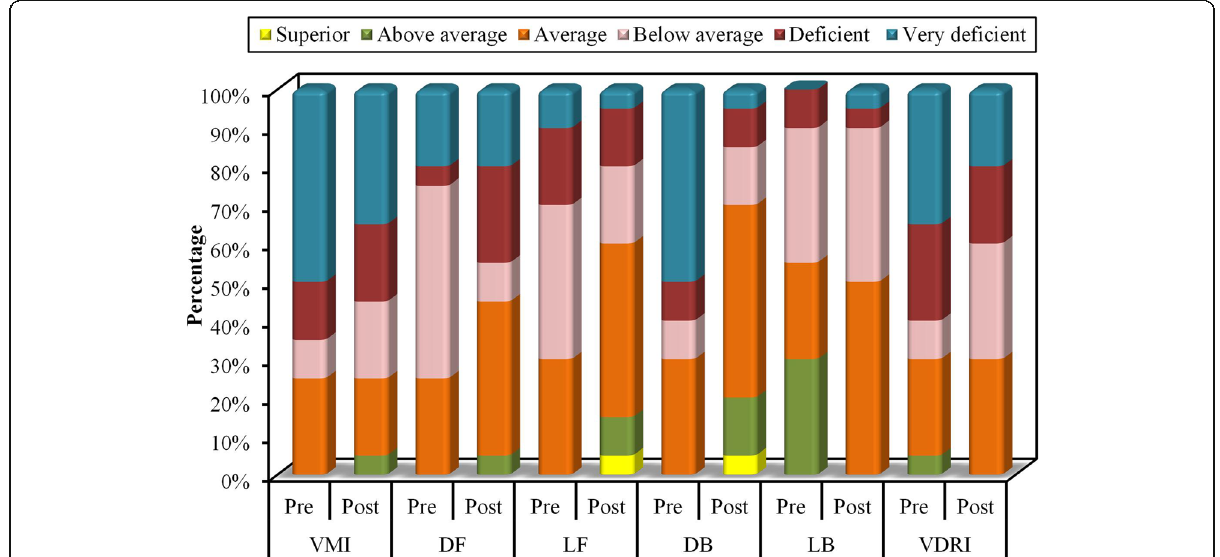
Fig. 3 Percentage of prelingual and postlingual patients lying in each category of TOMAL-2